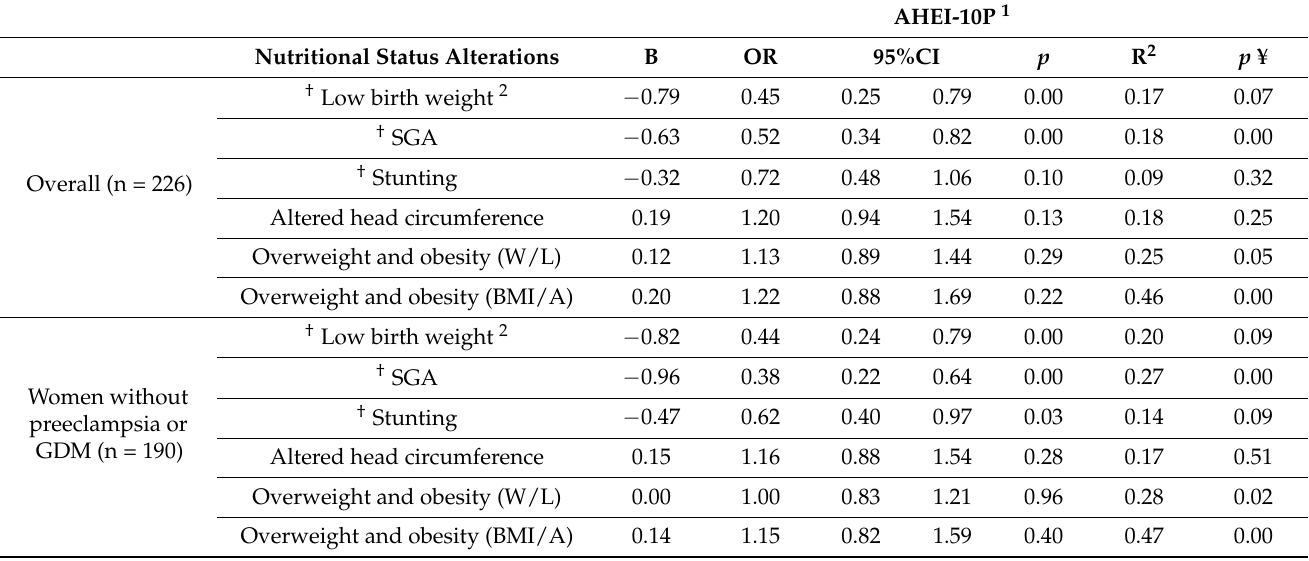
Table 6. Effect of diet quality on nutritional status